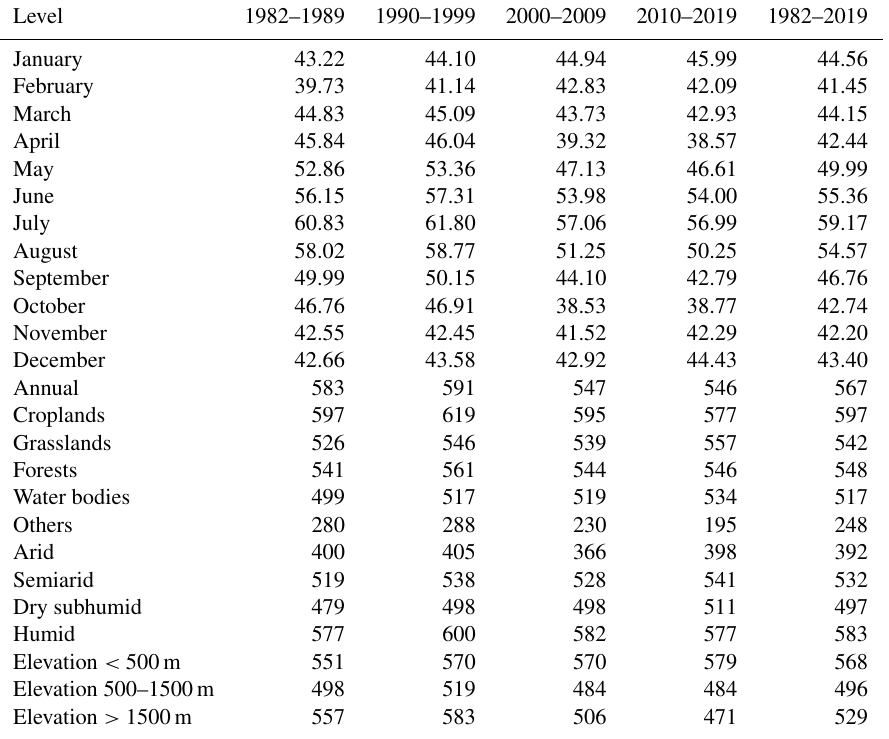
Table 10. The average decadal synthesized ET of monthly (mmmonth − 1 ), land cover types, aridity index classes, and elevation levels (mmyr − 1